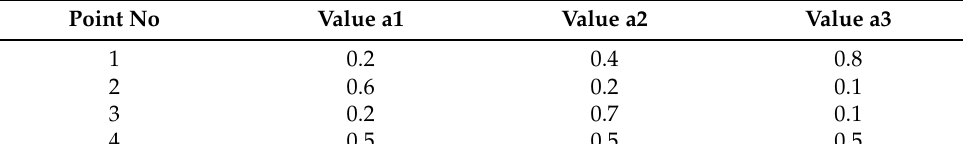
Table A1. Data table for 2-simplex.